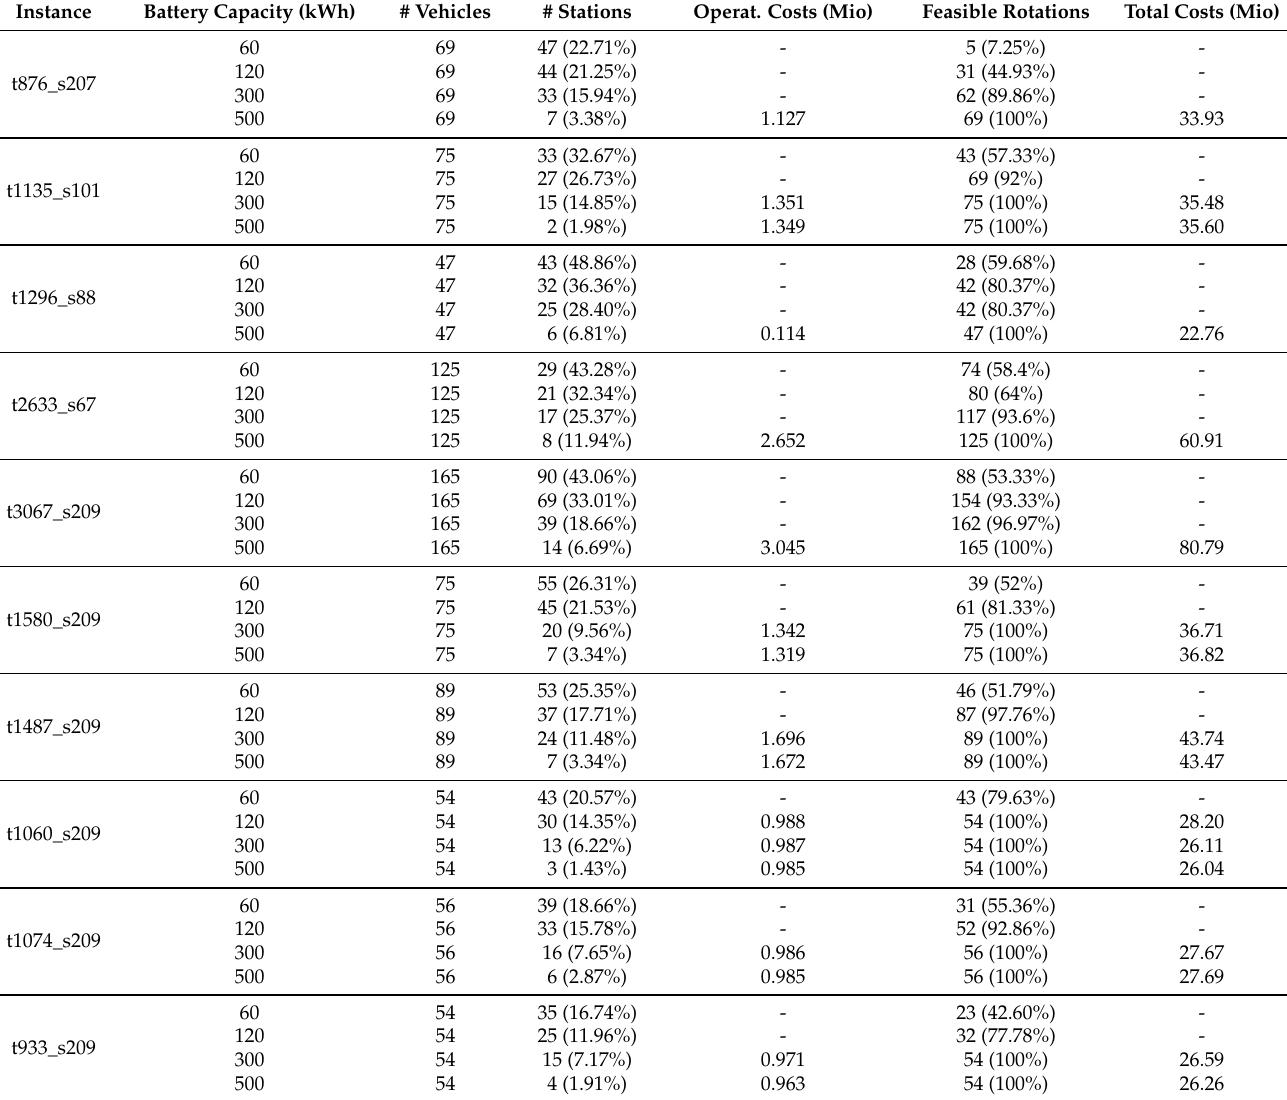
Table 2. Results of solving a location planning problem for charging stations for the electrification of cost-minimal vehicle rotations computed without range restrictions incorporating partial charging